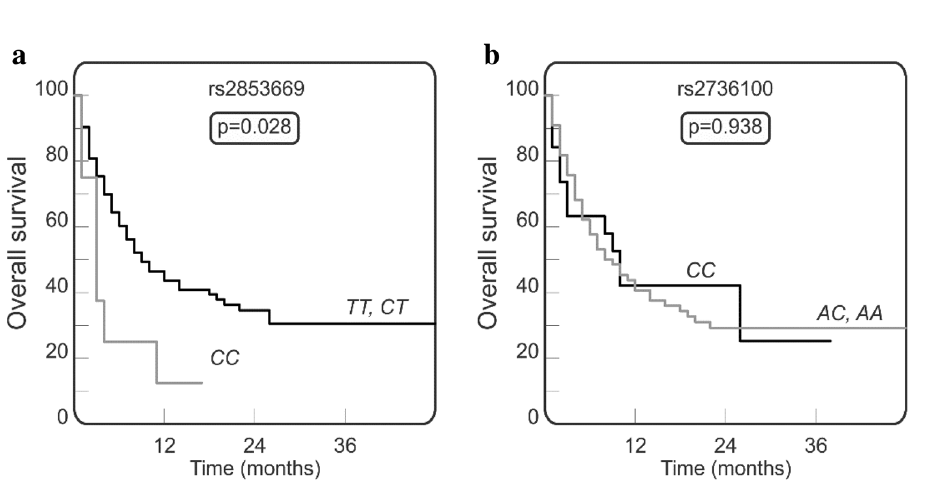
Figure 2. Overall survival in AML patients carrying various genotypes of TERT rs2853669 ( a ) and TERT rs2736100 ( b ). The homozygous rs2853669 CC genotype is associated with shorter overall survival ( a ). The Gehan-Breslow-Wilcoxon test was used for statistical